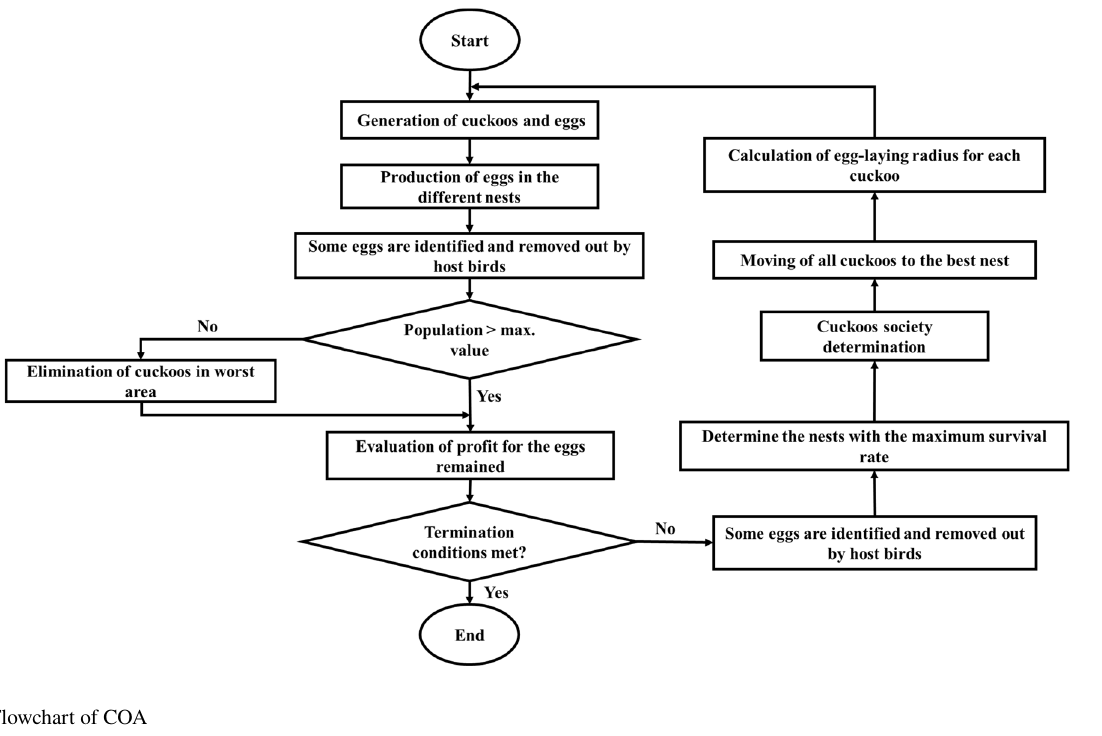
Fig. 19 Flowchart of